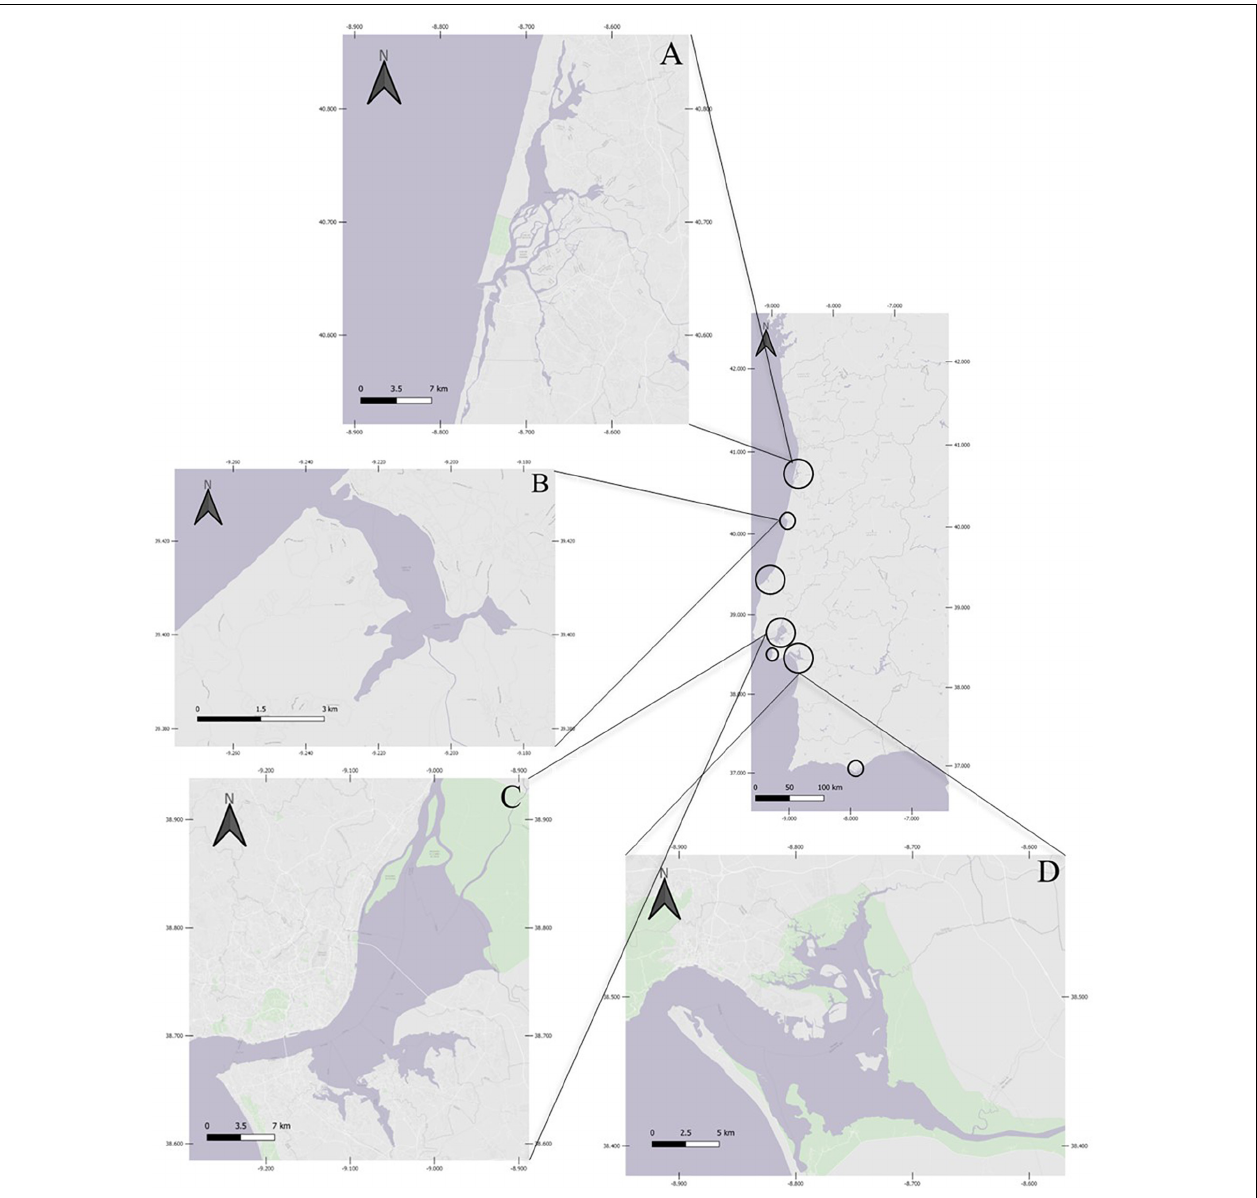
FIGURE 1 | Locations of estuaries and coastal lagoons where the Manila clam ( Ruditapes philippinarum ) has been recorded. From north to south of Portugal: Ria de Aveiro (A) , Mondego Estuary, Óbidos Lagoon (B) , Tagus Estuary (C) , Albufeira Lagoon, Sado Estuary (D) and Ria Formosa. The letters mark the systems addressed in this